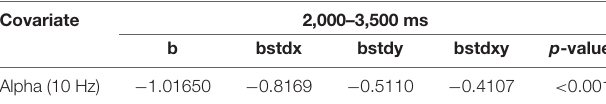
TABLE 2 | Analytic results of EEG power spectra over time in the frontal midline cluster, using a logistic regression model (10 Hz). Covariate 2,000–3,500